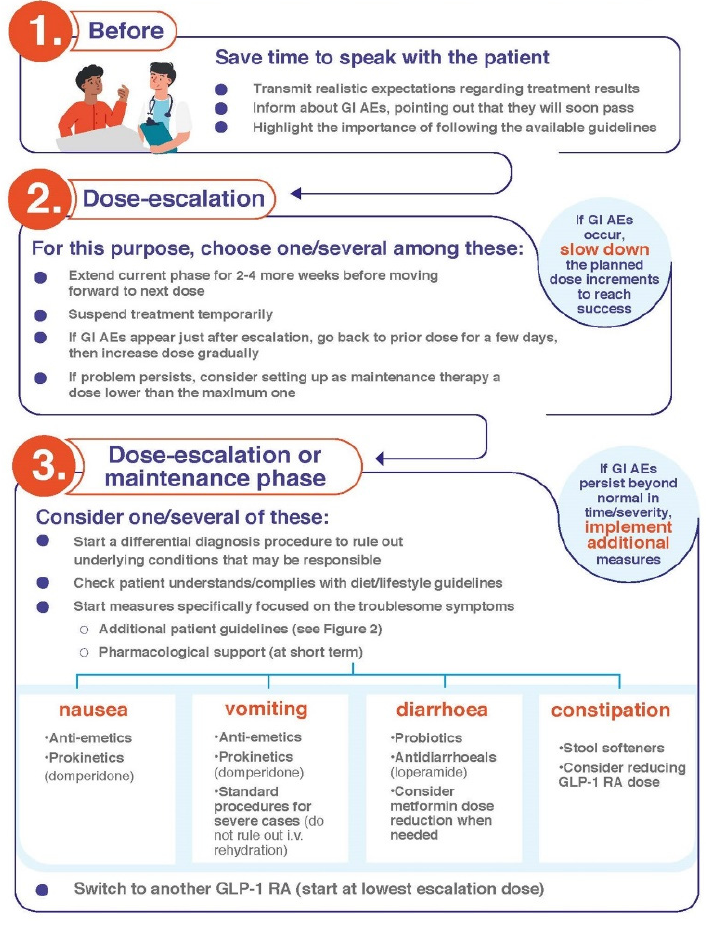
Figure 4. Minimizing occurrence/severity of GI AEs: the role of HCPs.